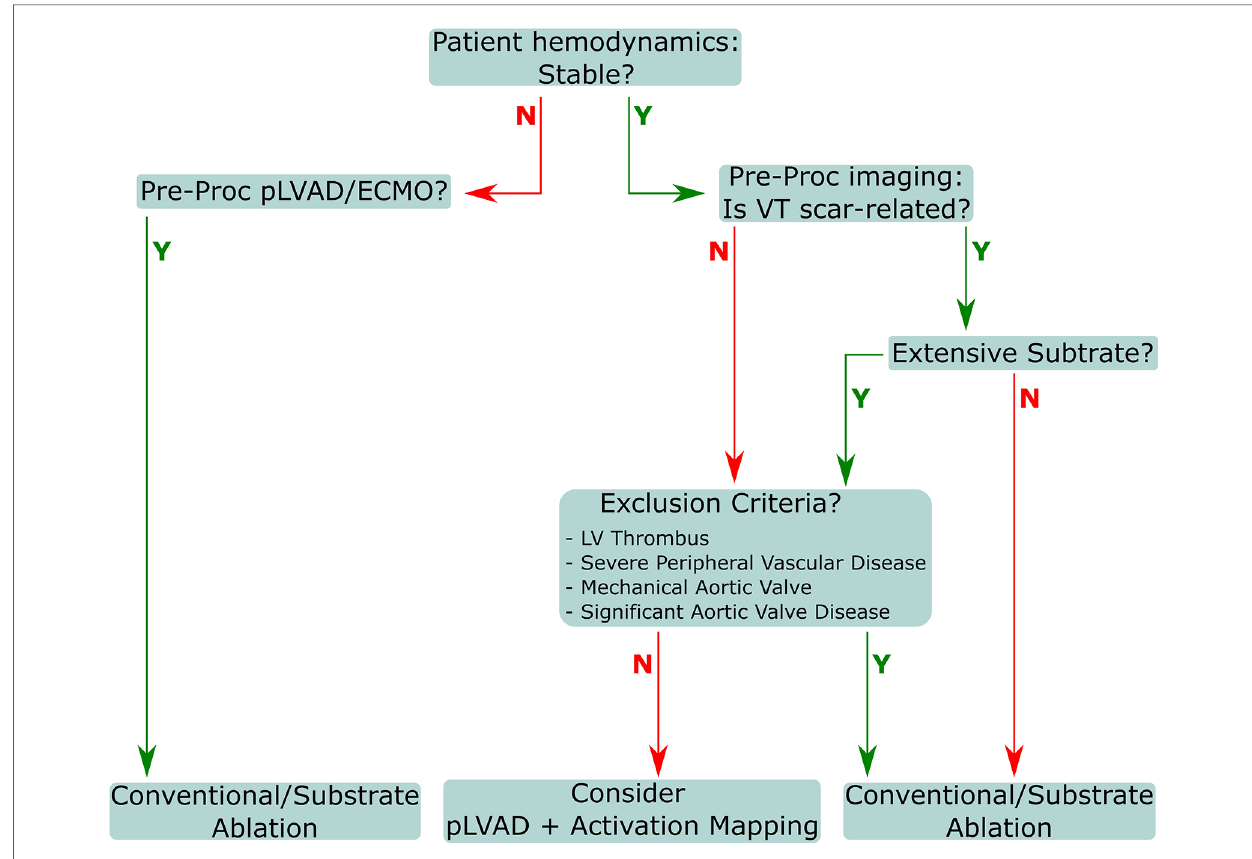
FIGURE 2 Patient evaluation fl ow for VT. VT, ventricular tachycardia; pLVAD, percutaneous left ventricular assistance device; ECMO, extracorporeal membrane oxygenation; LV, left